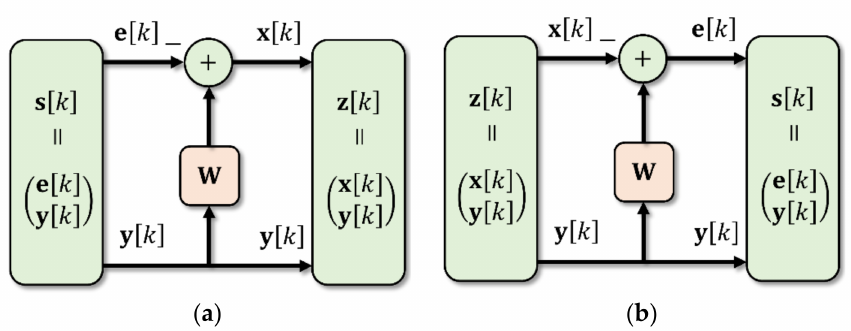
Figure 8. ( a ) Synthesis scheme; ( b ) analysis